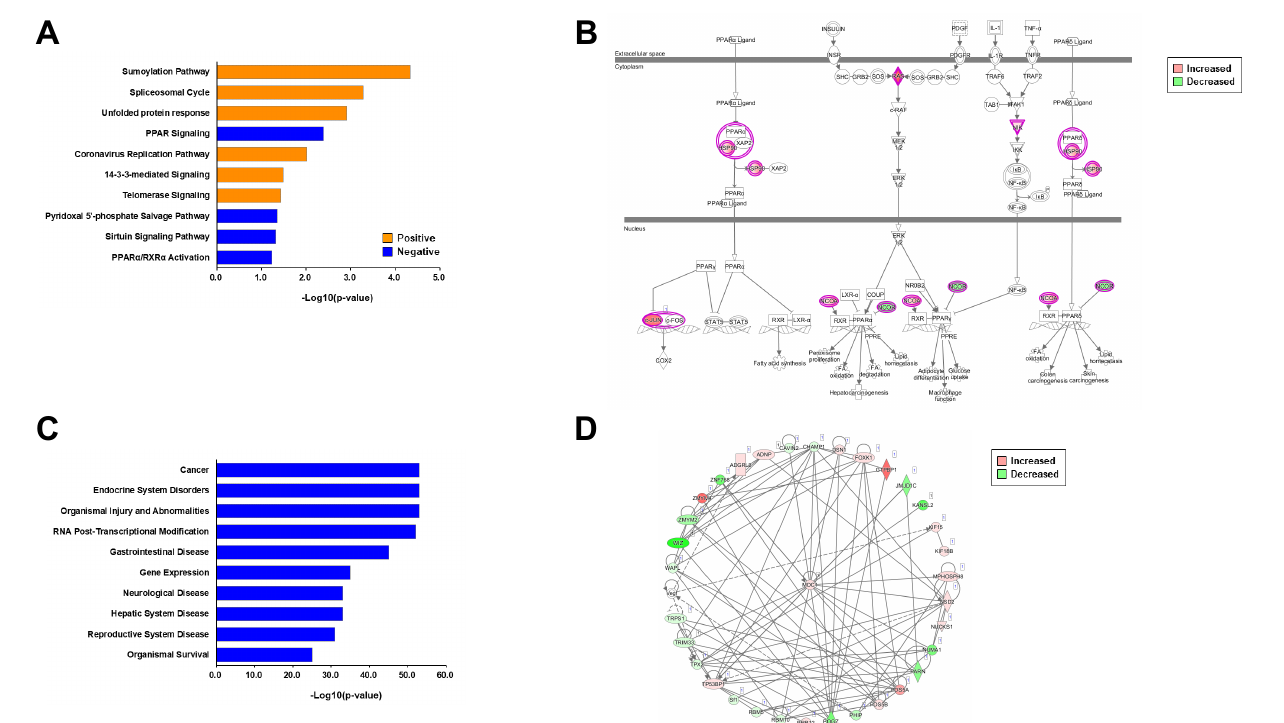
Figure 3. Informatic analysis of phosphoproteomes of palmitate-induced insulin-resistant conditions. ( A ) Canonical pathway enrichment analysis of the 689 phosphoproteins. The positive and negative z-scores are shown in orange and blue color, respectively. The x -axis indicates the − log10 ( p -value) of each pathway. ( B ) The peroxisome proliferator-activated receptor (PPAR) pathway as the representa- tive canonical pathway of phosphoproteomes of palmitate-induced insulin-resistant conditions. The increased and decreased phosphorylation levels are shown in red and green, respectively. ( C ) Top ten terms of disease relation and biological functions. The x -axis indicates the − log10 ( p -value) of each term. ( D ) Interactome analysis using the top1 term (cancer)-related phosphoproteins. The increased and decreased phosphorylation levels are shown in red and green,